Question: Express in one sentence what the figure is showing.
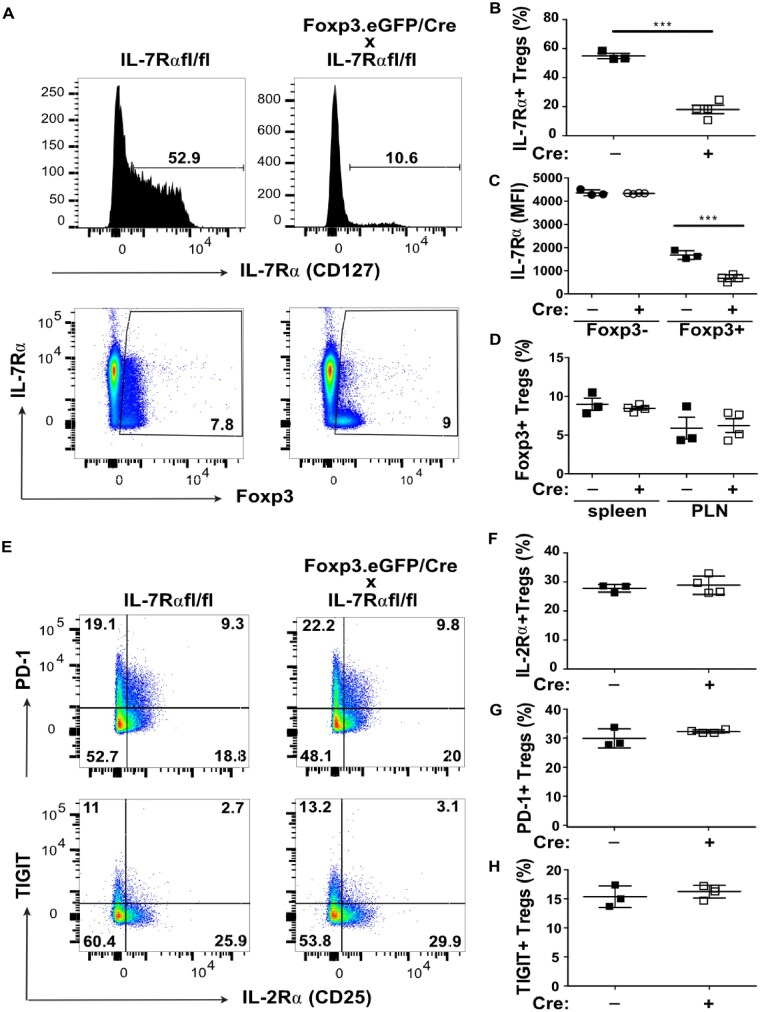
Answer: Cell-intrinsic loss of IL-7Rα expression does not alter the frequency and phenotype of Foxp3 + Tregs in young NOD mice. PLNs and spleens were harvested from 4-wk old NOD.IL-7Rα fl/fl and NOD.Foxp3.eGFP/Cre × IL-7Rα fl/fl mice and cell suspensions stained with fluorescently-labeled mAbs to detect Foxp3, IL-7Rα, CD25, PD-1 and TIGIT by flow cytometry. (A) Upper panels: Representative histograms show IL-7Rα expression in Foxp3 + Tregs from NOD.IL-7Rα fl/fl (Cre-) and NOD.Foxp3.eGFP/Cre × IL-7Rα fl/fl (Cre+) mice. Lower panels: Representative dot plots show frequencies (%) of Foxp3 + Tregs within the CD4 + T cell gate. Summary graphs show percentages of (B) IL-7Rα-expressing cells within the CD4 + Foxp3 + gate, (C) IL-7Rα expression levels (MFI) in Foxp3 neg vs Foxp3 + CD4 + T cells from both mouse strains ( n = 3–4), and (D) Foxp3 + cells within CD4 + T cells ( n = 3–4). (E) Representative dot plots show PD-1 and TIGIT expression vs CD25 expression gated on CD4 + T cells. Graphs show the percentages of (F) CD25 + , (G) PD-1 + , and (H) TIGIT + cells within the CD4 + Foxp3 + Treg gate from NOD.IL-7Rα fl/fl ( n = 3) and NOD.Foxp3.eGFP/Cre × IL-7Rα fl/fl ( n = 4) mice. *** = P < 0.001.